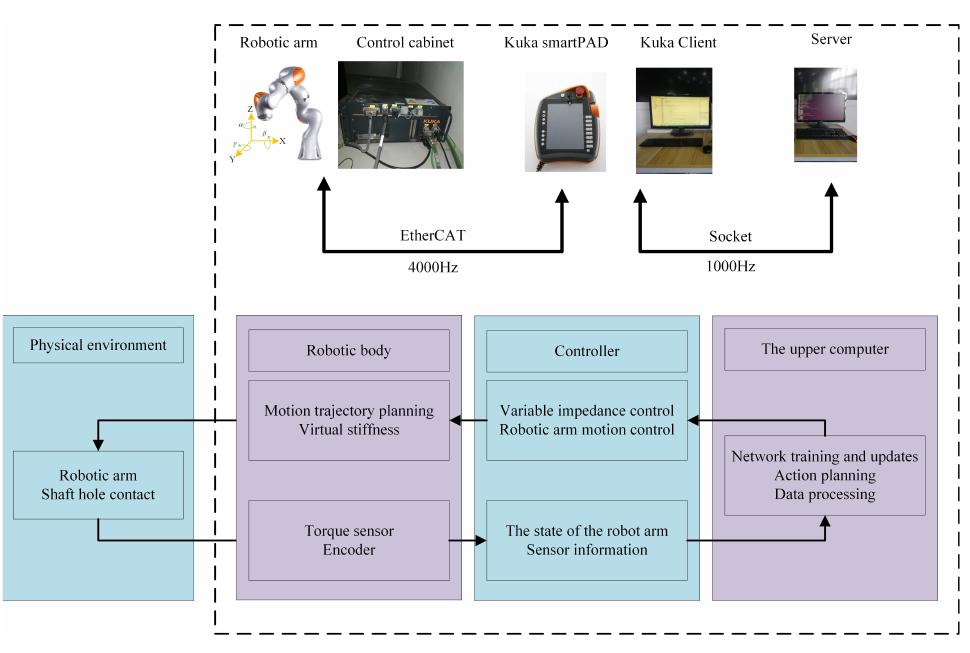
Figure 5. Communication structure of assembly system. Table 3. Initial setting of each assembly